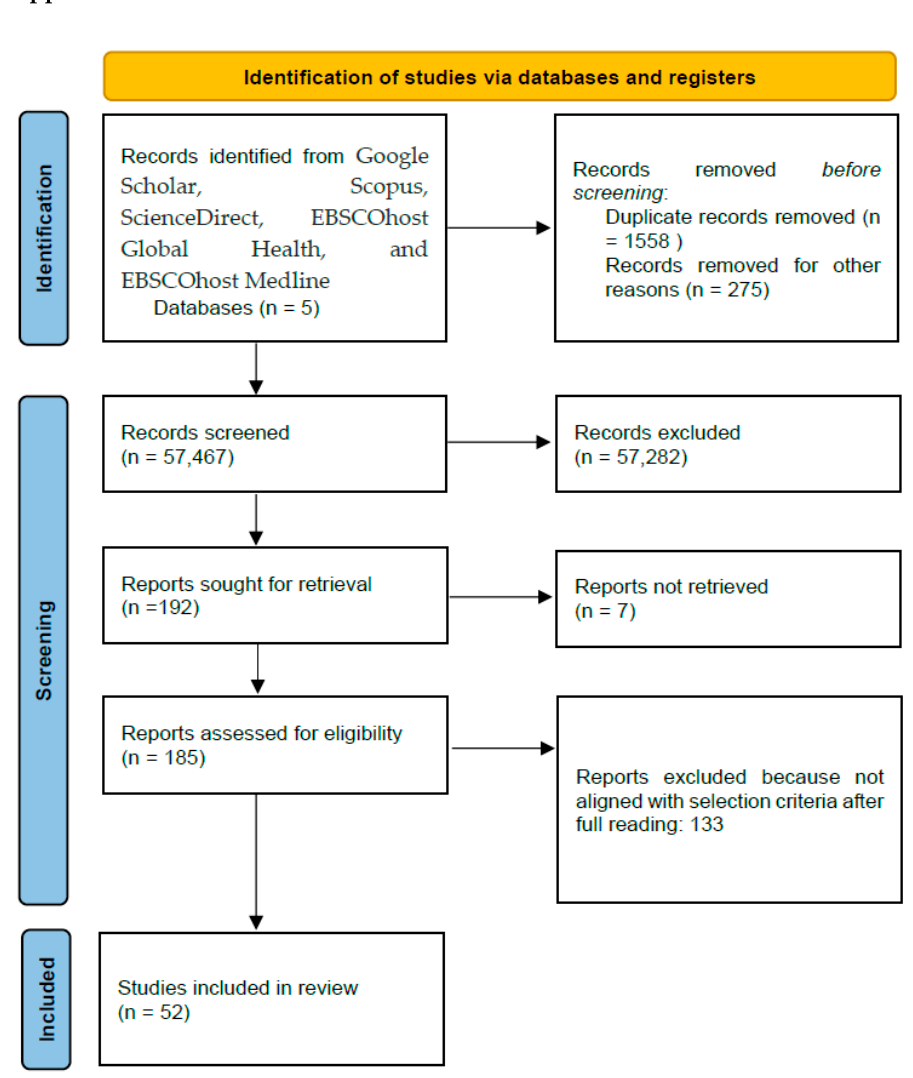
Figure A1. PRISMA flow diagram for identification of relevant articles for systematic review. Table A1. Demographic characteristics of surveyed children